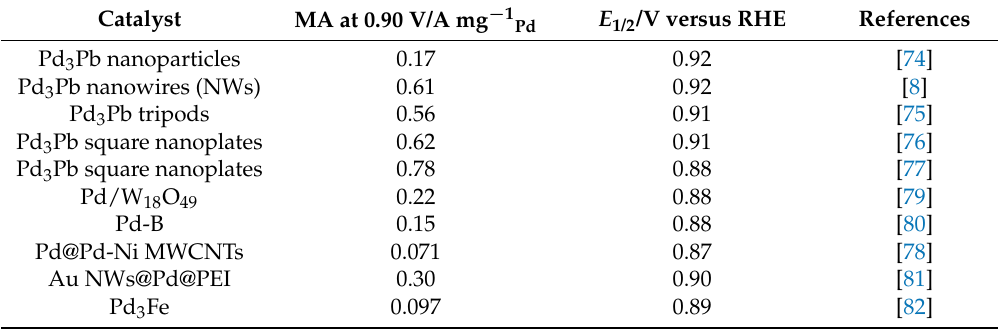
Table 2. MA at 0.9 V (versus RHE) and half-wave potentials ( E 1/2 ) for ORR by various Pd-based catalysts in an O 2 -saturated 0.1 M KOH aqueous